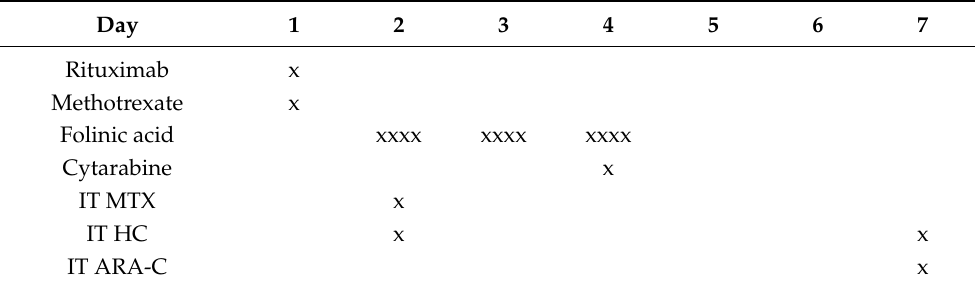
Table 4. Treatment according to the B-HR arm of the Inter-B-NHL-COP 2010 with dose reduction of methotrexate, without methotrexate dose